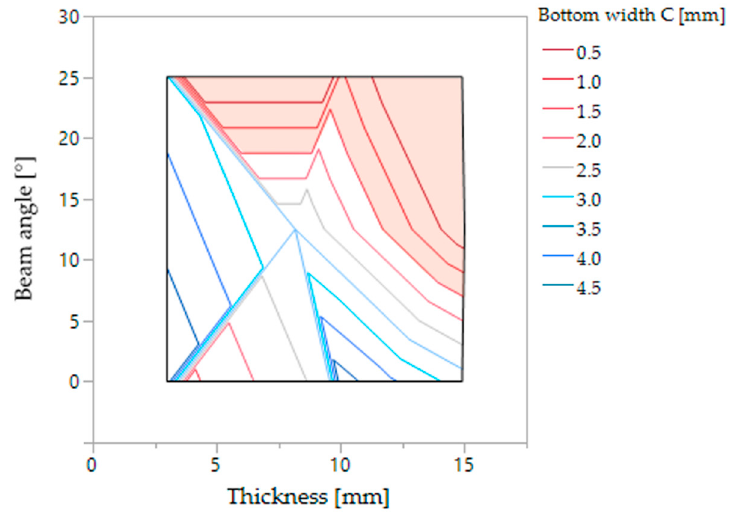
Figure 11. Contour plot for bottom width C on the two-dimensional space formed by the parameters thickness and beam angle. Infeasible region for complete penetration are coloured in light red.